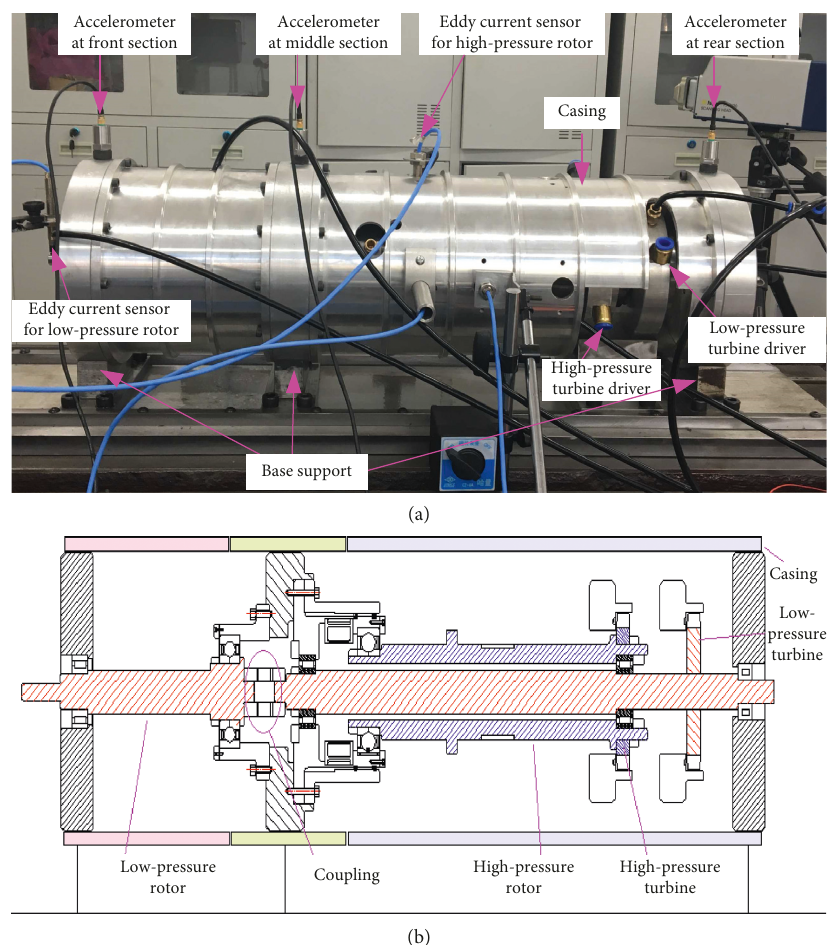
Figure 14: Dual-rotor-casing rig. (a) Test layout and (b) cutaway view.